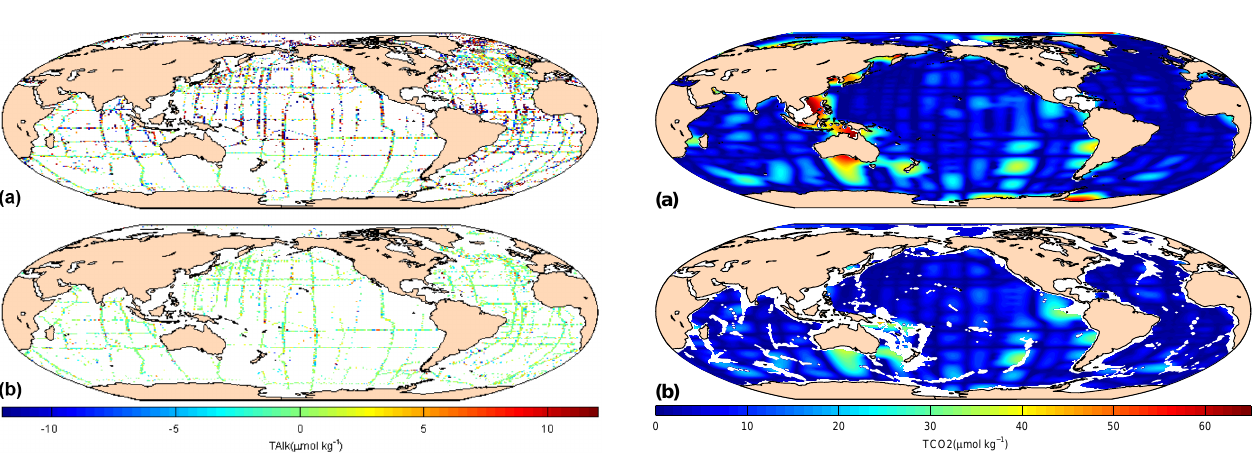
Figure 7. Difference between the gridded TAlk input data and the mapped climatologies at 10m (a) and 3000m (b) .